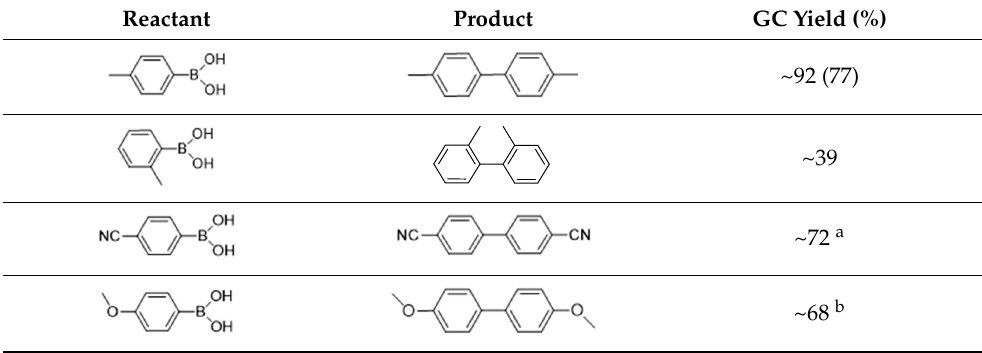
Table 3. Homocoupling reaction of various arylboronic acids using 20AuMPT particles.